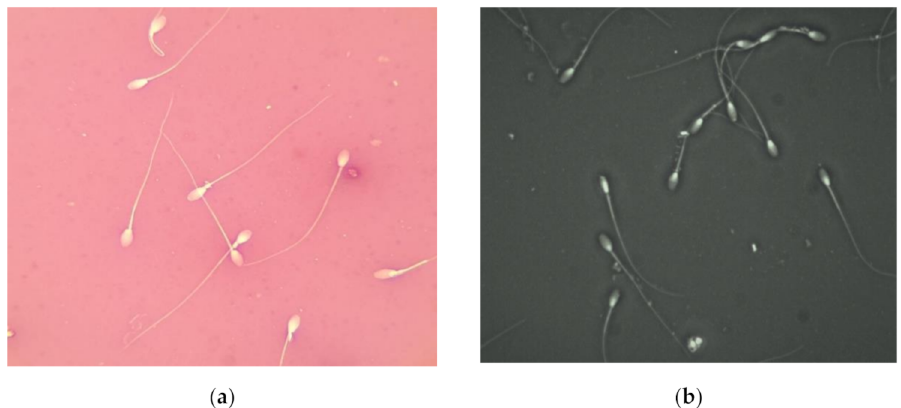
Figure 1. Sperm morphology of stallion. ( a ) Stallion sperm stained using eosin-nigrosin stain at × 1000 magnification; ( b ) immobilized stallion sperm using Trumorph ® technique at × 400